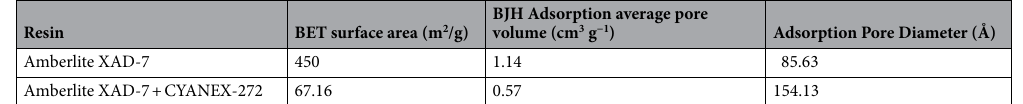
BET analysis. Table 3 presented the results of surface area and porosity analysis of A XAD-7 resin before and after impregnation with CYANEX-272. XAD-7 resin size 0.3–0.85 mm was used as support. According to the obtained results, BET Surface area and BJH adsorption average pore volume of Amberlite XAD-7 resin decreases after the impregnation process, which is due to the filling of the resin pores by CYANEX-272 organic molecules. In addition, the increase in the pore diameter of SIR indicates that in the impregnation process, first the smaller pores and then the larger pores are filled with CYANEX-272 organic molecules. The surface area and porosity analysis showed the successful saturation of the Amberlite XAD-7 resin by CYANEX-272 22 . Preliminary evaluation of the impregnation process. Preliminary experiments performed for the adsorption of Ce(ΙΙΙ) and La(ΙΙΙ) using pure Amberlite XAD-7 resin showed that the Ce(ΙΙΙ) and La(ΙΙΙ) percentage adsorption on the XAD-7 resin is very low. To investigate the impact of the impregnation process on the XAD-7 resin adsorption rate, Ce(ΙΙΙ) and La(ΙΙΙ) adsorption tests were performed using SIR. According to the results presented in Table 4, the percentage adsorption of Ce(ΙΙΙ) and La(ΙΙΙ) on SIR was significantly increased and this indicates the positive effect of CYANEX-272 impregnation on XAD-7 resin ability for Ce(ΙΙΙ) and La(ΙΙΙ) ions adsorption.